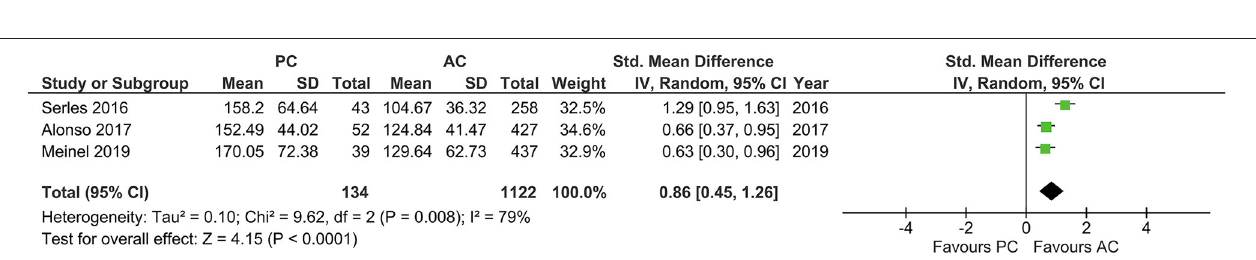
Frontiers in Neurology |